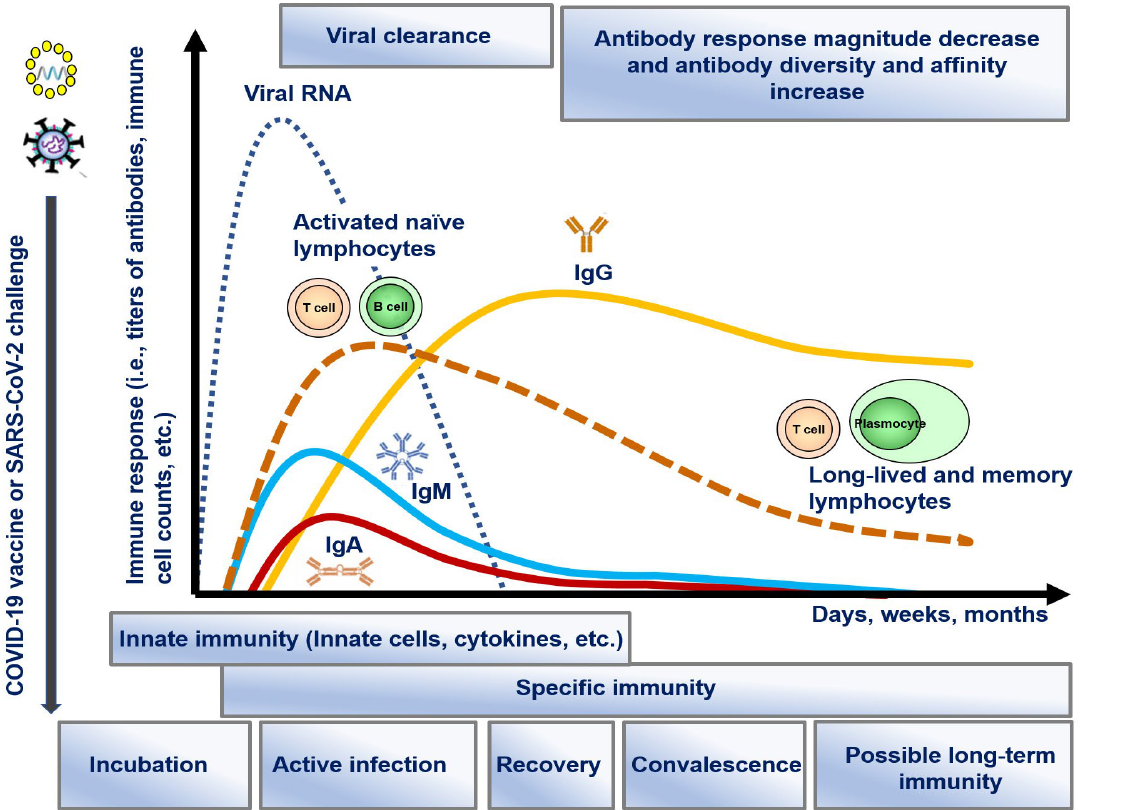
Figure 1. Dynamics of immune response development after encountering SARS-CoV-2, including innate immunity involvement and specific (adaptive) immune mechanisms (activation of T and B cells and production of antibodies), leading to viral clearance possible development of long-lived and memory lymphocytes together with matured and more affinity and diverse antibodies in the post-infection and convalescent period. The same immune response is activated after vaccination (on the figure—RNA vaccine), without the infection periods and viral load in the